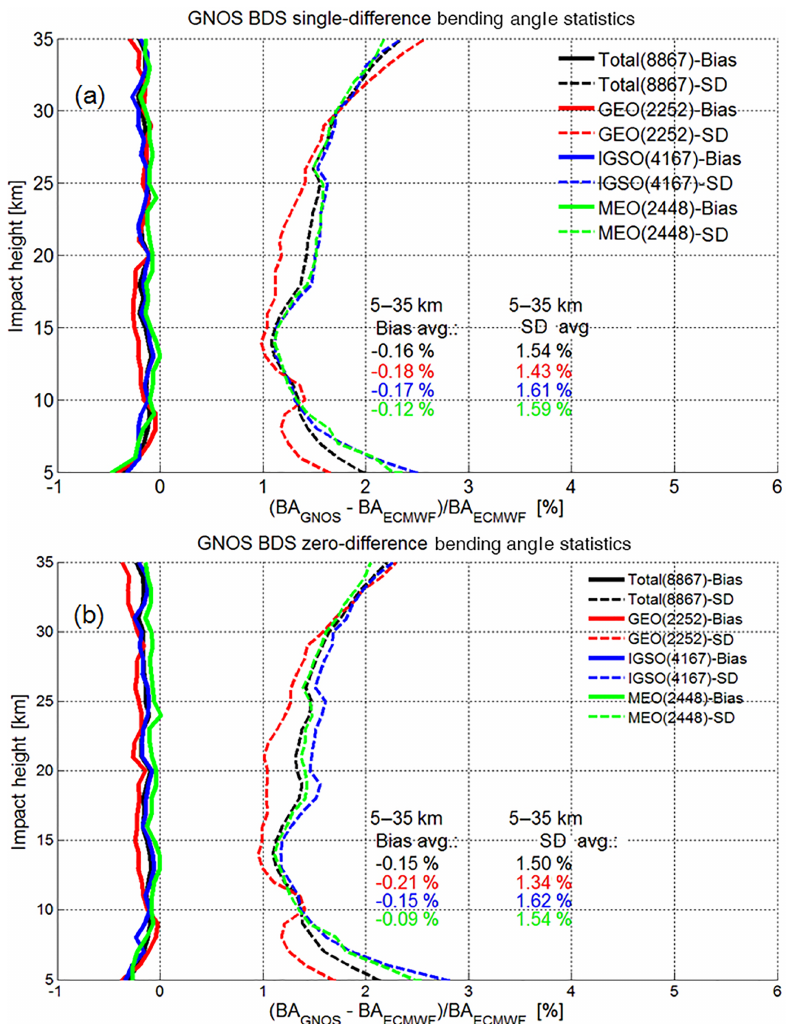
Figure 7. Mean difference (bias) and standard deviation (SD) statistics of the GNOS bending-angle profiles retrieved by using excess phases from the single-difference processing (a) and the zero-difference processing (b) , respectively, with the co-located ECMWF bending-angle profiles used as reference. Bias (solid) and SD (dashed) profiles are shown for the set of all BDS RO events (black), and the subsets of BDS-GEO (red), BDS-IGSO (blue), and BDS-MEO (green). Legends also indicate the number of events involved (the joint set of RO events from both the single- and zero-difference processing) and the average bias and SD values over the 5–35km